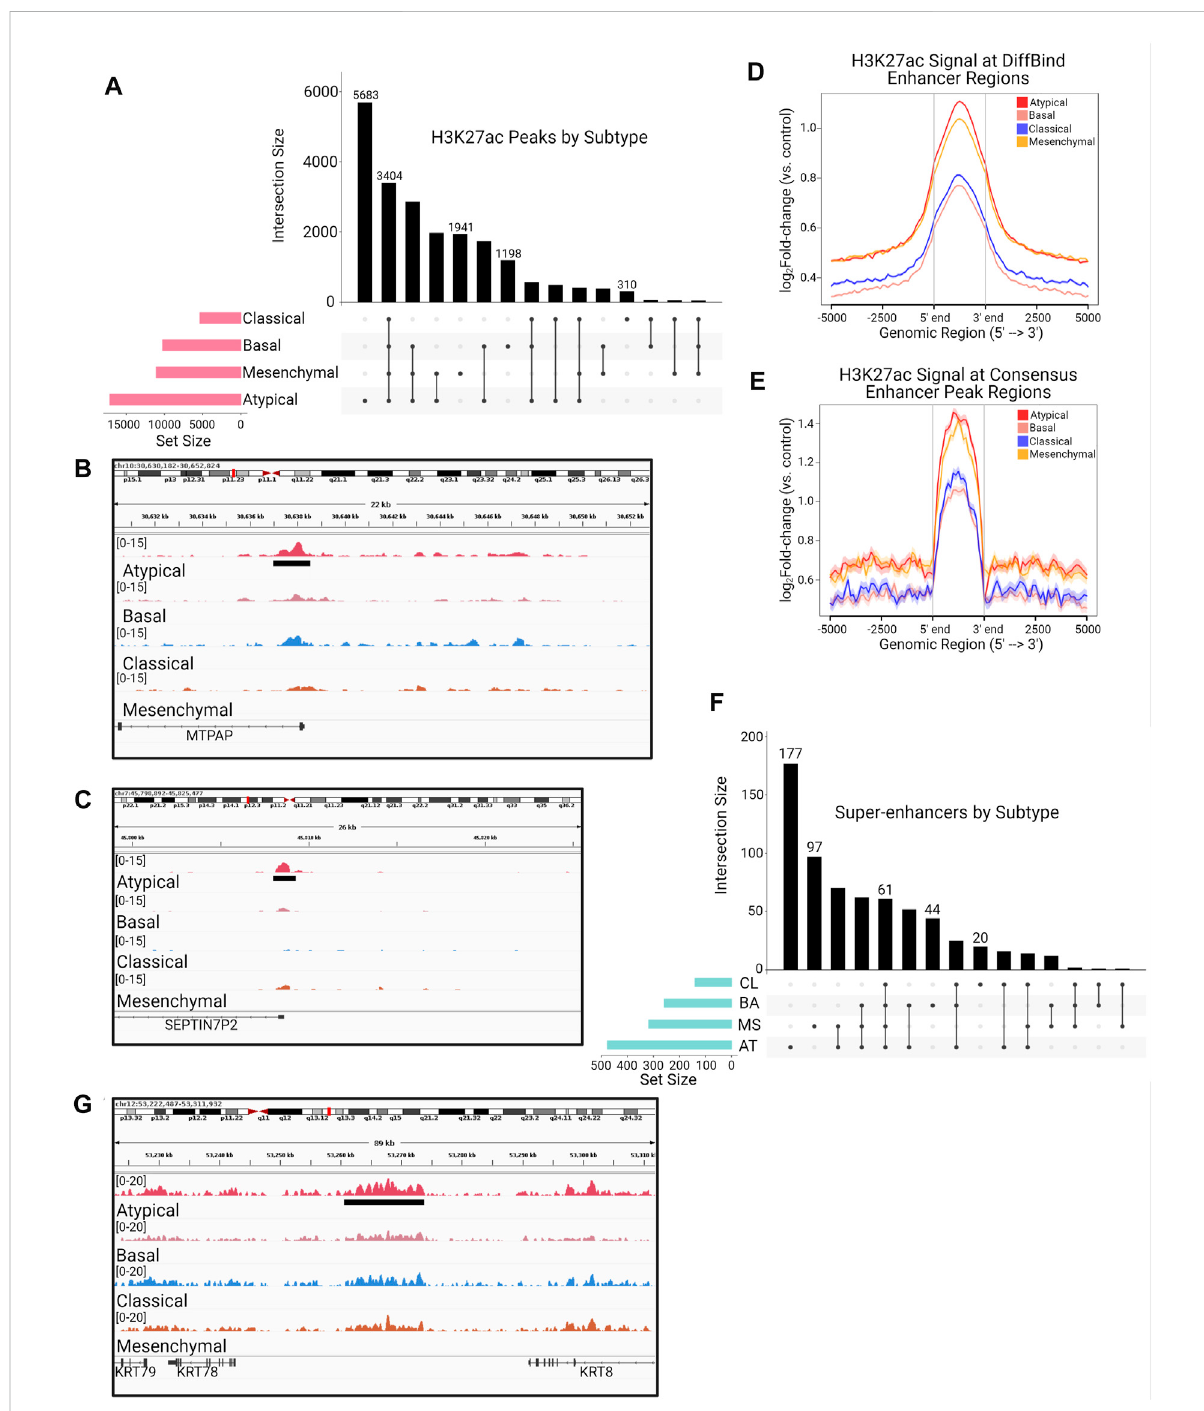
FIGURE 2 The Atypical subtype is associated with unique enhancer peaks regulating genes related to lipid metabolism and MAPK signaling. (A) UpSet plot showing the total number of H3K27ac typical enhancer peaks in each molecular subtype (pink horizontal barplot), as well as the number of peaks in each possible intersection of peaksets (black bars and dot plot). (B , C) Visualization of mean bigWig signal for each subtype at (B) MAP3K8 and (C) IGFBP3 enhancer locicontaining H3K27acpeaks unique to theAT subtype (green bar/grey shading). (D , E) H3K27acChIP-seq enrichment plots of enhancer loci common to all HNSCC molecular subtypes, de fi ned as (D) any peak contained within 2 or more individual samples or (E) the 3,404 peaks shared among all consensus peaksets in (A) , demonstrating the strongest signal in the AT subtype. (F) UpSet plot showing the total numberofsuperenhancerpeaksineachmolecularsubtype(bluehorizontalbarplot),aswellasthenumberofsuperenhancerpeaksineachpossible intersection of peaksets (black bars and dot plot). (G) Visualization of mean bigWig signal for each subtype at a MAP3K12 super enhancer containing peaks unique to the AT subtype (green bar/grey shading).